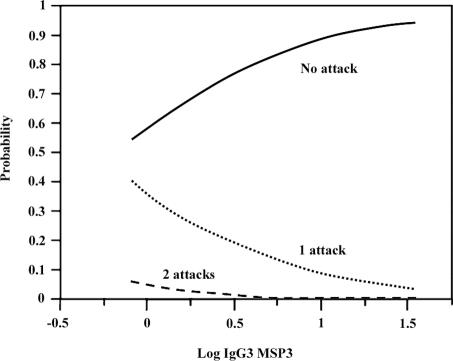
The Probability of No, One, or Two Malaria Attacks in the Adults of Dielmo as a Function of the Level of Anti-MSP3 IgG3 ResponsesThe chance of no attack increased markedly and almost reached a maximum in parallel with the gradual increase in anti-MSP3b IgG3 responses. The probability that one or two malaria attacks occurred in adults decreased as the anti-MSP3b IgG3 responses increased.